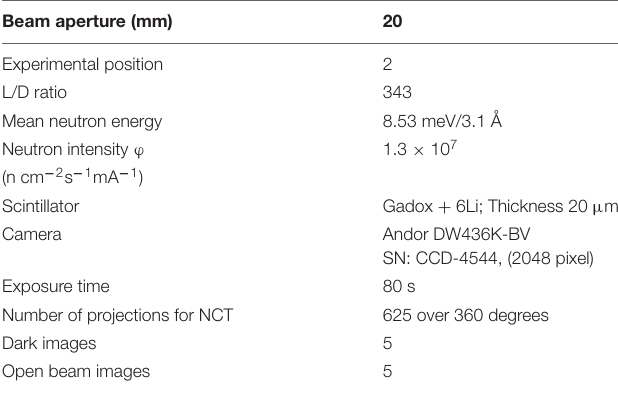
TABLE 3 | Neutron imaging parameters used at